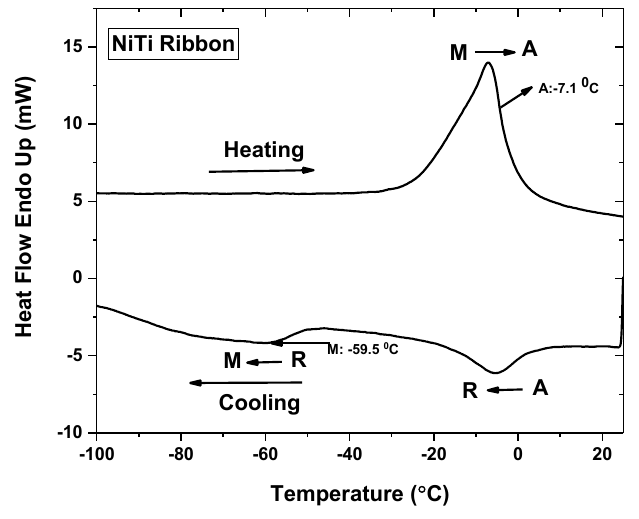
Figure 1. Phase transformation temperature of Ni-Ti ribbon with austenitic (As) and martensitic (Ms) phases.